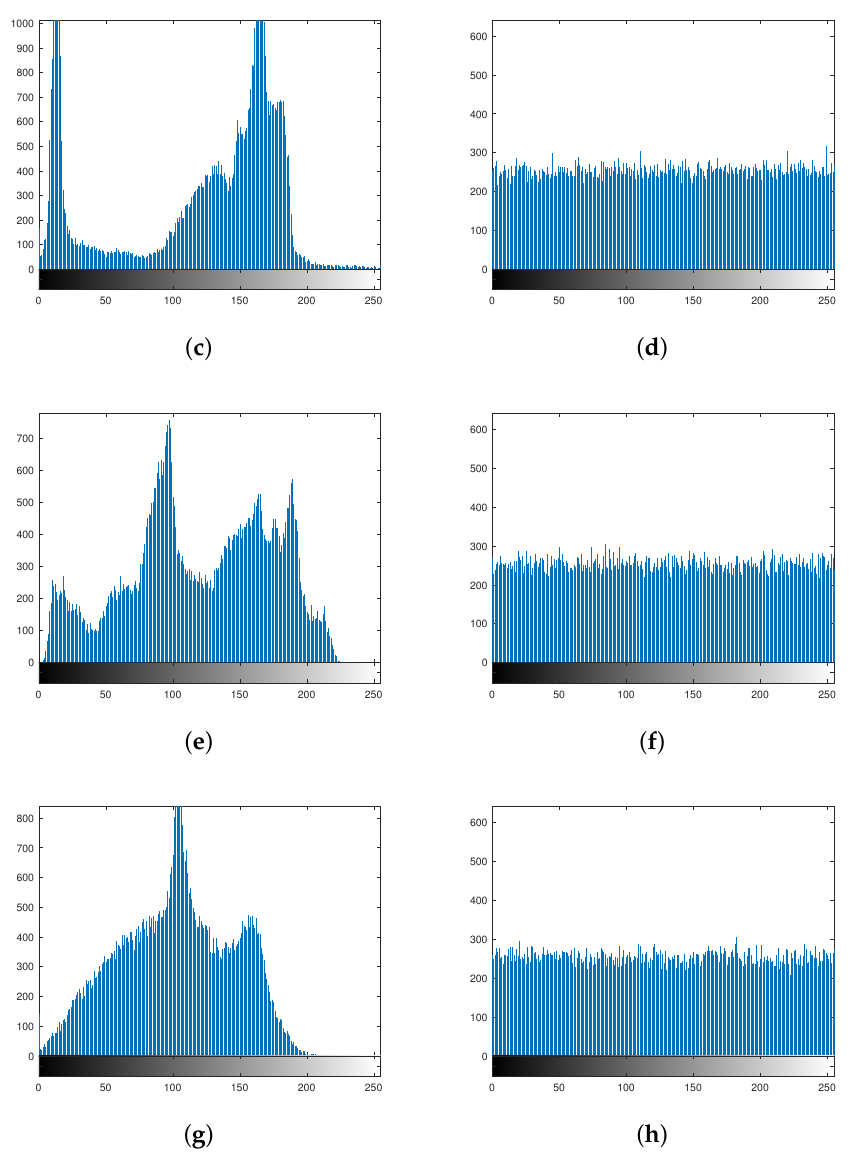
Figure 11. Histograms. ( a , b ) are histograms of the Lena image and the encrypted Lena image. ( c , d ) are histograms of the Cameraman image and the encrypted Cameraman image. ( e , f ) are histograms of the Pepper image and the encrypted Pepper image. ( g , h ) are histograms of the Baboon image and the encrypted Baboon